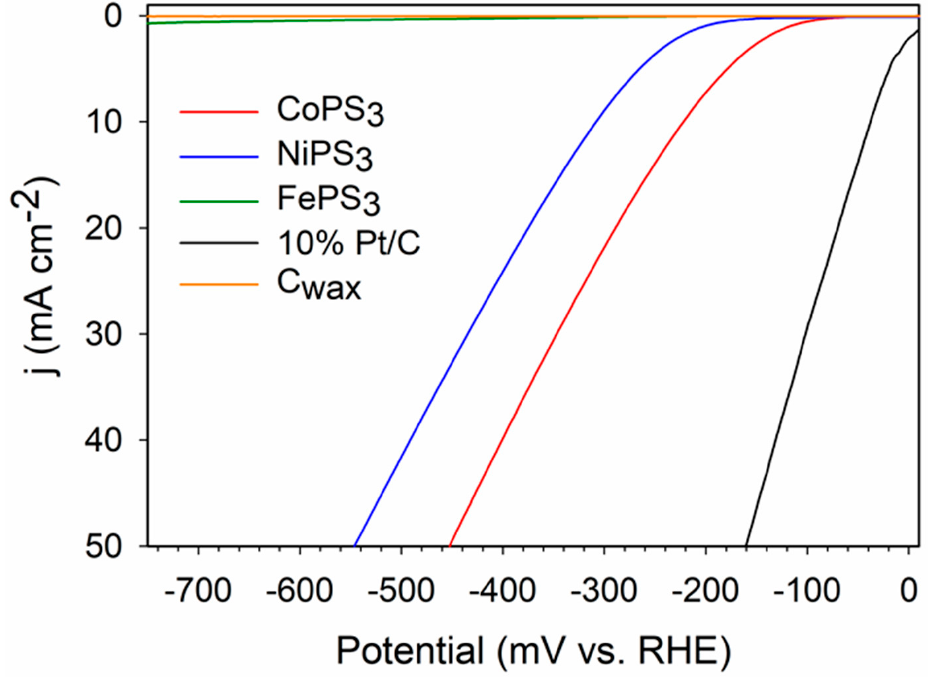
Figure 7. Representative LSV plots for the three MPS 3 samples (M = Fe, Co, Ni), a C wax blank, and 10%Pt on C powder on C wax electrodes in 0.5 M H 2 SO 4 (5 mV/s scan rate, with no iR compensation). Data with 85% iR compensation applied are listed in Table 3 and LSV data are in Supplementary Figures Table 3. Summary of key electrochemical and electrocatalytic HER results for MPS 3 materials 1. Catalyst Material Onset (mV) 2